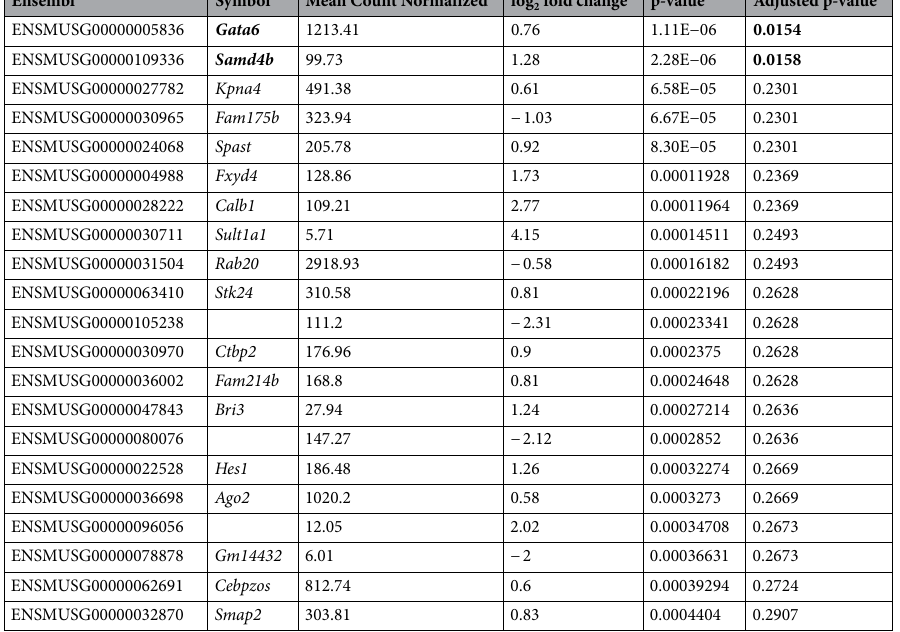
Table 1. Top 20 differentially expressed genes when comparing 8-cell stage embryos fathered by males on a high fat vs control diet. A positive log 2 fold change indicates upregulation in HFD embryos whereas a negative log 2 fold change denotes increased expression in control diet embryos. Significant genes following multiple testing correction are highlighted in bold.